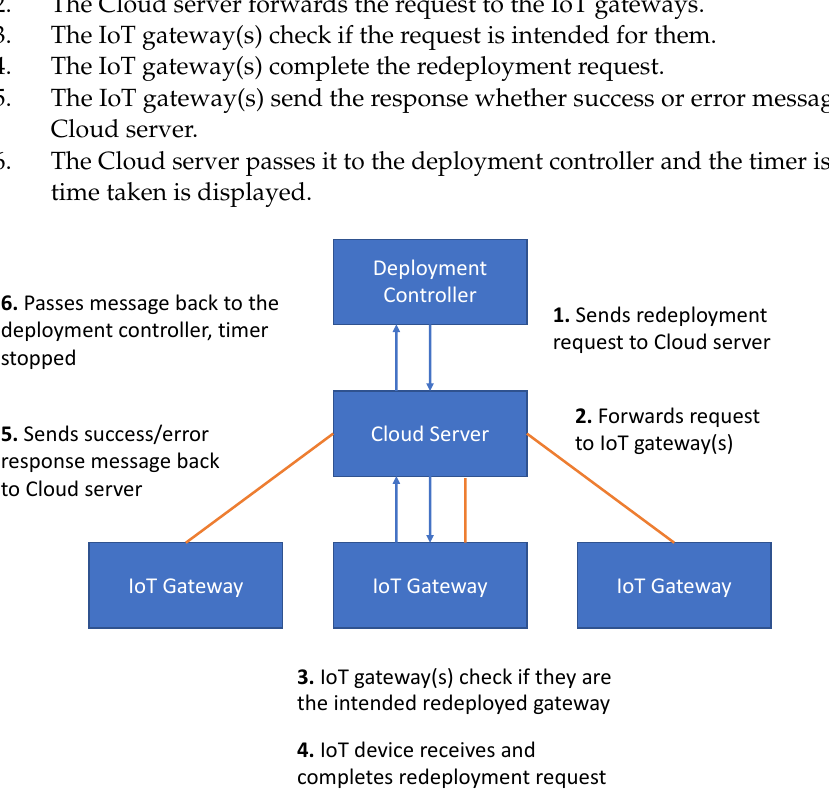
Figure 8. Scenario 2: Redeployment process across multiple IoT